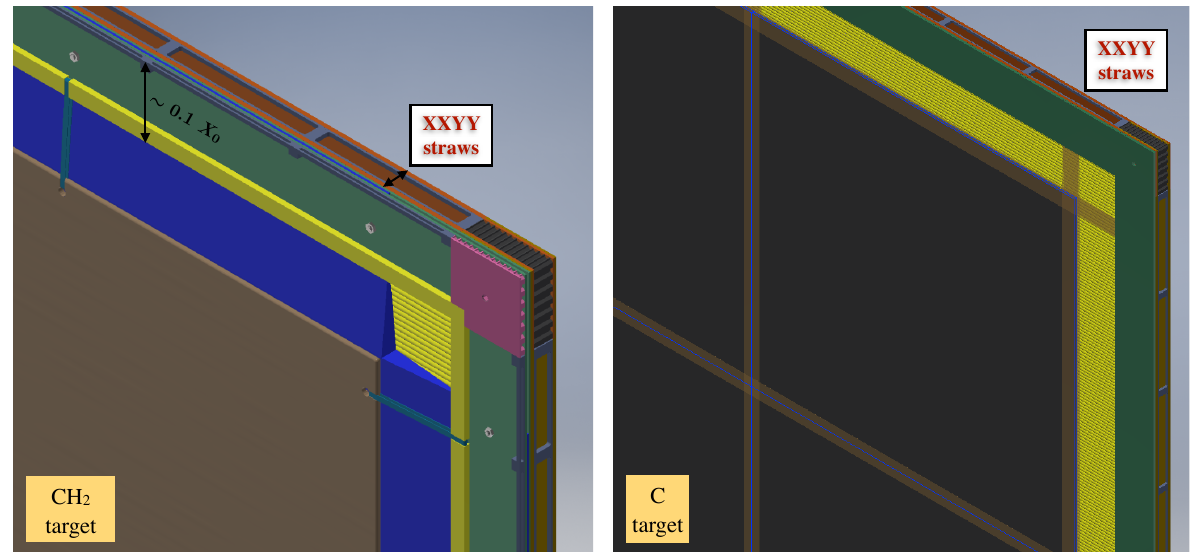
Figure 128. ( Left ): Detailed 3D engineering CAD model of one STT module equipped with CH 2 target slab (in brown color) and radiator (in blue color). The average density of the detector can be fine tuned between 0.005 g/cm 3 (without target slab and radiator) and 0.18 g/cm 3 (configuration in the drawing). Both the target slab and the radiator can be unmounted during data taking by removing four corner screws. ( Right ): Engineering CAD model of of one STT module equipped with graphite target (in black color). The tracking part is composed of four straw layers XXYY and is the same as in the CH 2 module on the